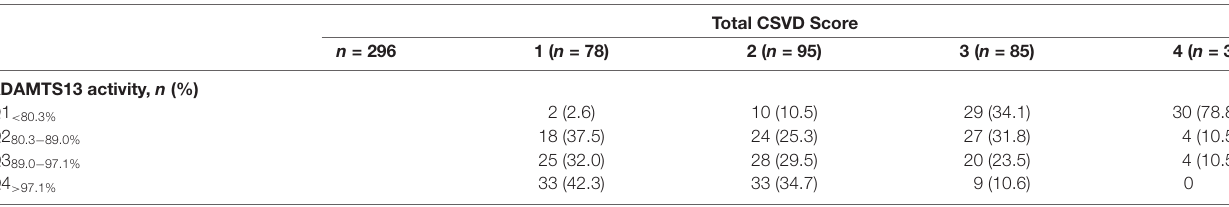
TABLE 4 | The characteristics of ADAMTS13 activity of the patients with total CSVD score.